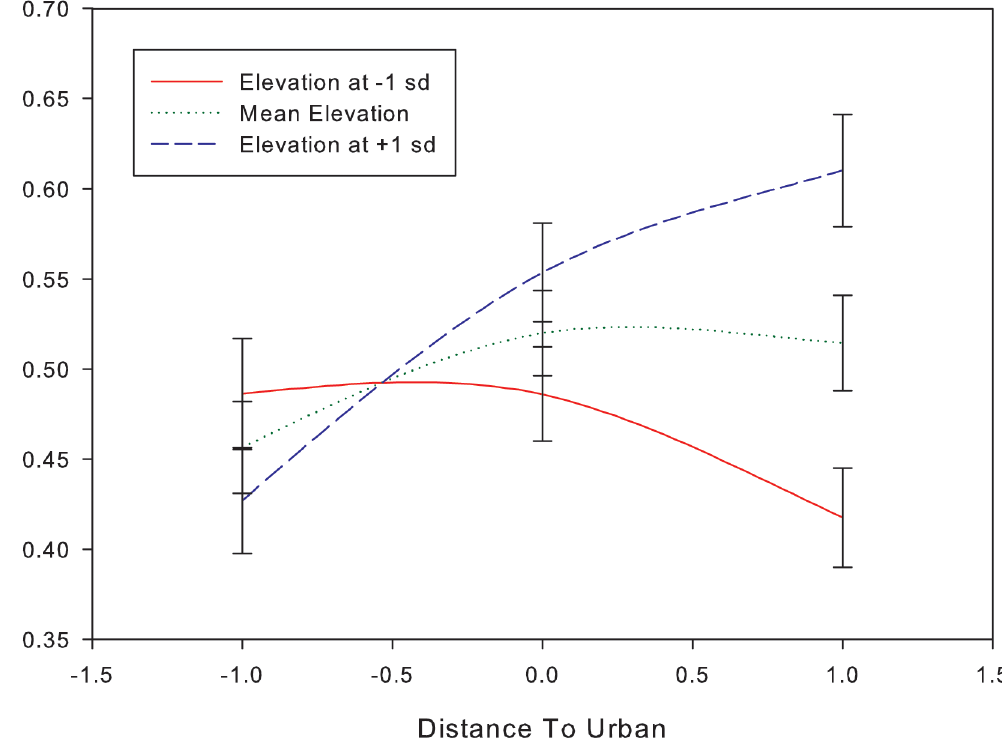
Fig 3. The interaction effect of elevation on distance to urban for predicting conservation easement location. As elevation departs from its mean ( ± 1SD), the effects of distance to urban area on probability of easement location becomes stronger.